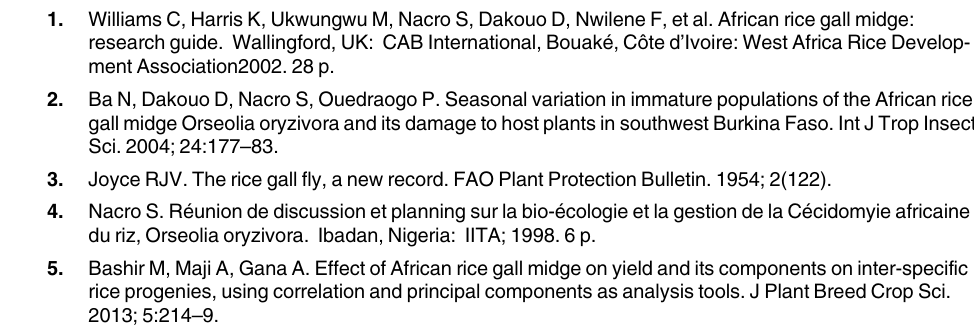
populations. S1 Table. Consensus linkage map positions for 641 SNP markers used for genotyping the three mapping positions. S2 Table. Summary of model selection criteria in the